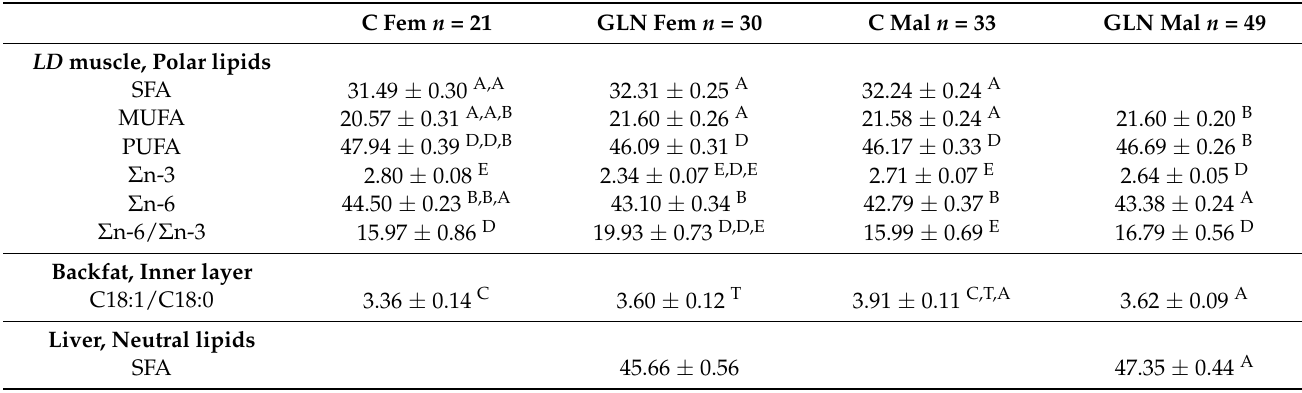
Table 7. Significant differences in tissue fatty acid (FA) compositions between control (C) and treated (GLN) pigs of both sexes at the slaughterhouse. LSmean ± SE (g/100 g total FA) of C and GLN females (Fem) and males (Mal). C Fem n = 21 GLN Fem n = 30 C Mal n = 33 LD muscle, Polar lipids